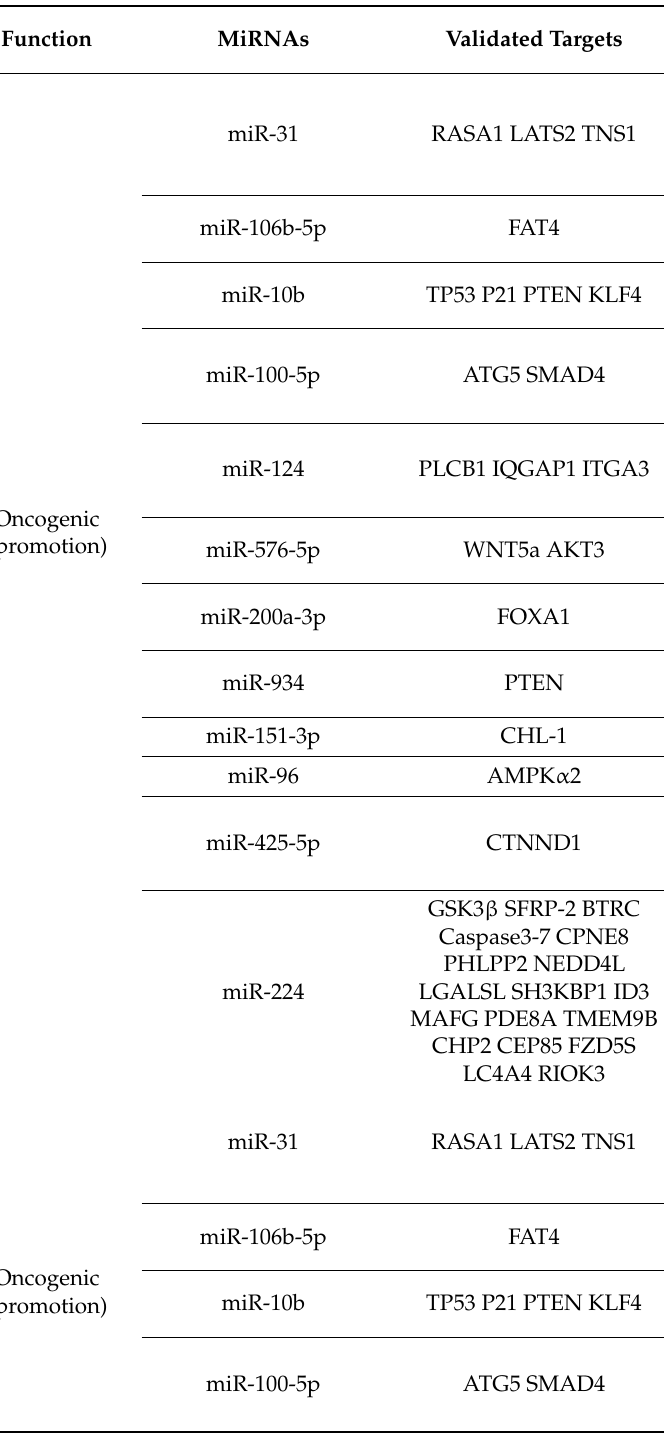
Table 1. MiRNAs involved in CRC